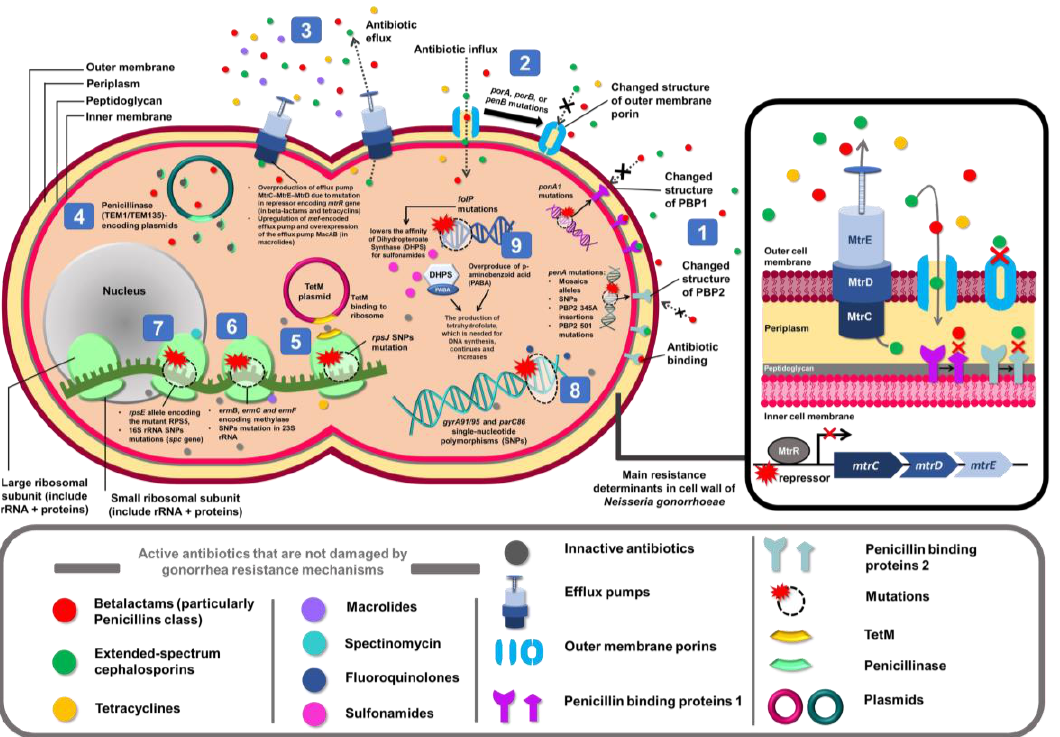
Figure 1. Resistance mechanisms of various antibiotics combating N. gonorrhoeae isolates. (1) Penicillin- binding proteins (PBP) mutations in beta-lactams and cephalosporins resistance; (2) Genes mutations encoding porin in beta-lactams, cephalosporins, and tetracyclines resistance; (3) Overexpression of Mtr- CDE pumps increase antimicrobials' efflux (beta-lactams, cephalosporins, and tetracyclines) due to repressor gene mutation, alongside upregulation of mef - and macAB -encoded efflux pumps increase macrolides efflux; (4) Hydrolyzation of the ß-lactam ring by plasmid-encoded penicillinase in beta-lactams; (5) A single nucleotide polymorphisms (SNP) mutation in the 30S ribosomal protein ( rpsJ ) and plasmid- encoded TetM protein lower tetracyclin affinity to a ribosome; (6) 23S rRNA SNPs mutation and methylation by rRNA methylases (encoded by erm ) block macrolides binding to the ribosome; (7) A SNP mutation in 16S rRNA and rpsE encoding 30S ribosomal protein S5 mutant (RPS5) inhibit spectinomycin binding to the ribosome; (8) A SNP in DNA gyrase and topoisomerase reduces binding of fluoroquinolones to these enzymes for DNA synthesis blocking; (9) DHPS-encoding folP mutations and overproduction of PABA impairing sulfonamides effectivity and increases production of tetrahydrofolate. (Images